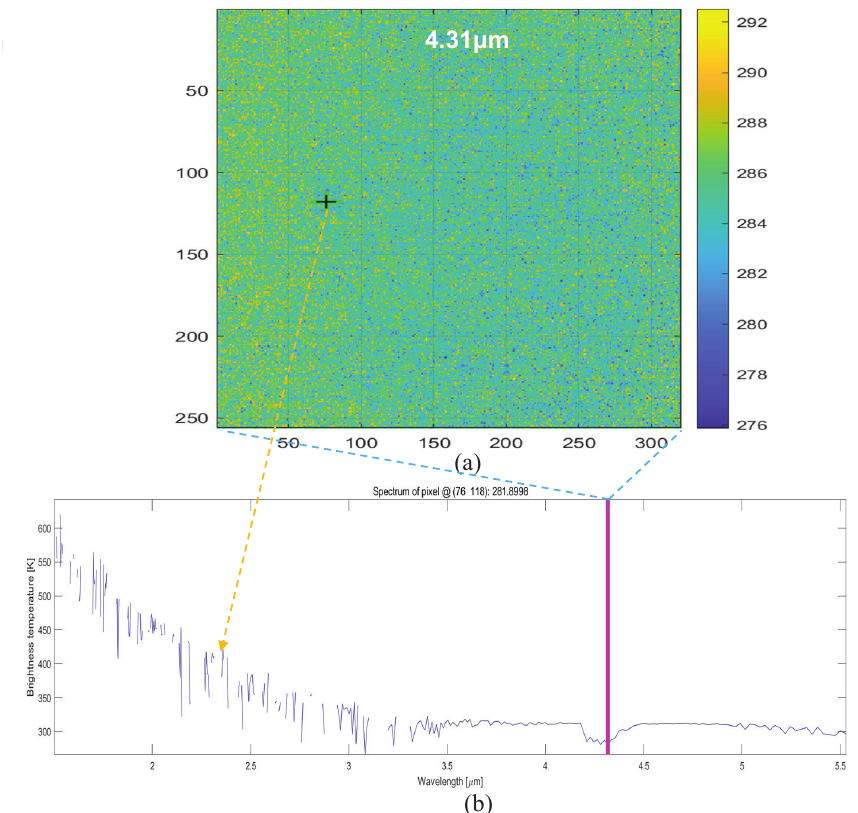
Figure 8. Air temperature map extraction using spectral radiance in the CO 2 absorption band: ( a ) the air temperature map at 4.31 µ m, ( b ) the brightness temperature profile at the cross point in ( a ). T tg separation module: The remote target temperature separation process requires two assumptions. One is that there must be a high atmospheric transmittance band; the other is that there must be high emissivity band. These assumptions can be satisfied